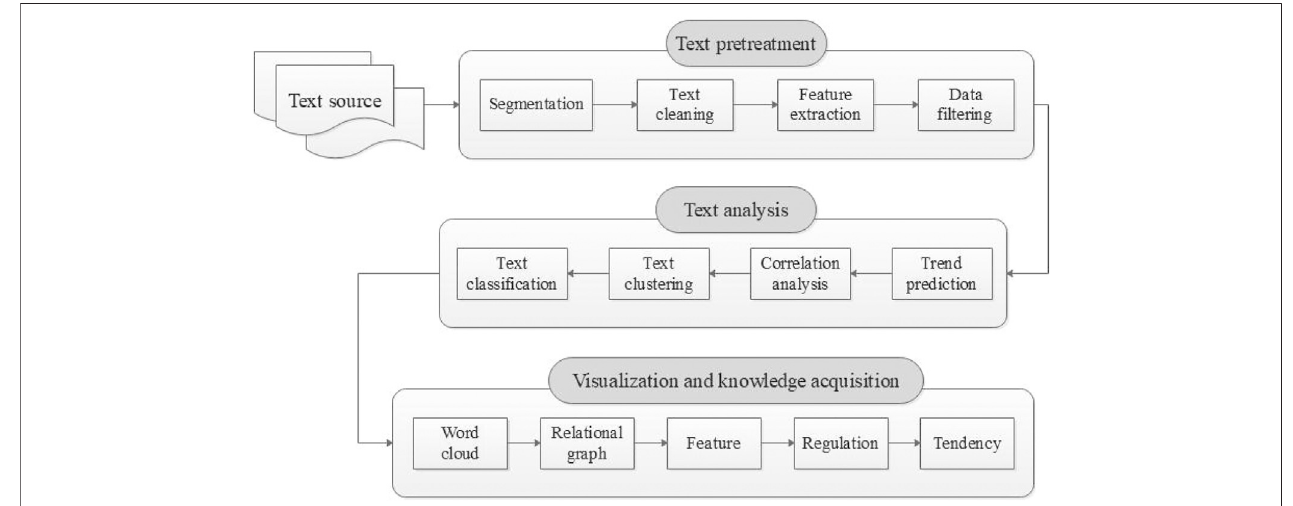
FIGURE 1 | General fl ow chart of the text data mining process.